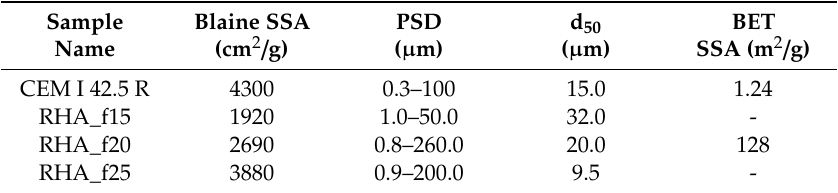
Table 5. Grinding